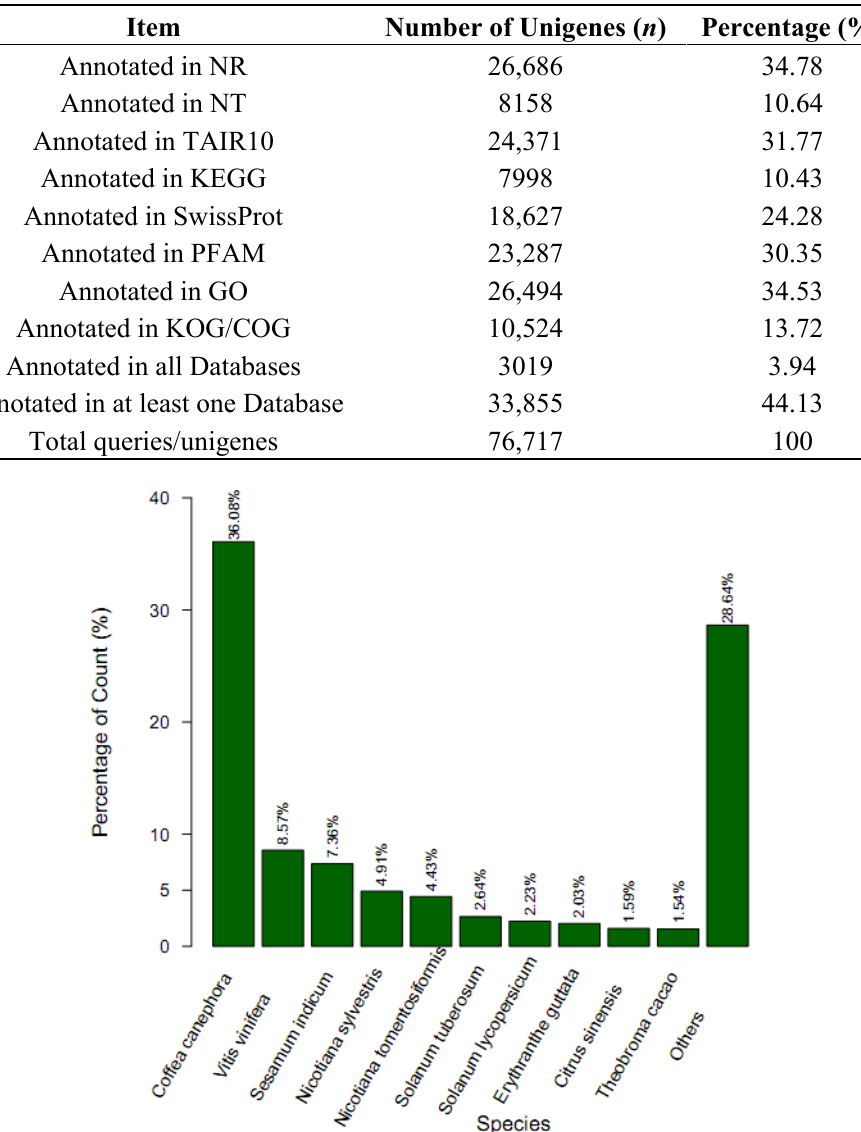
Table 3. Statistics result of gene annotation.